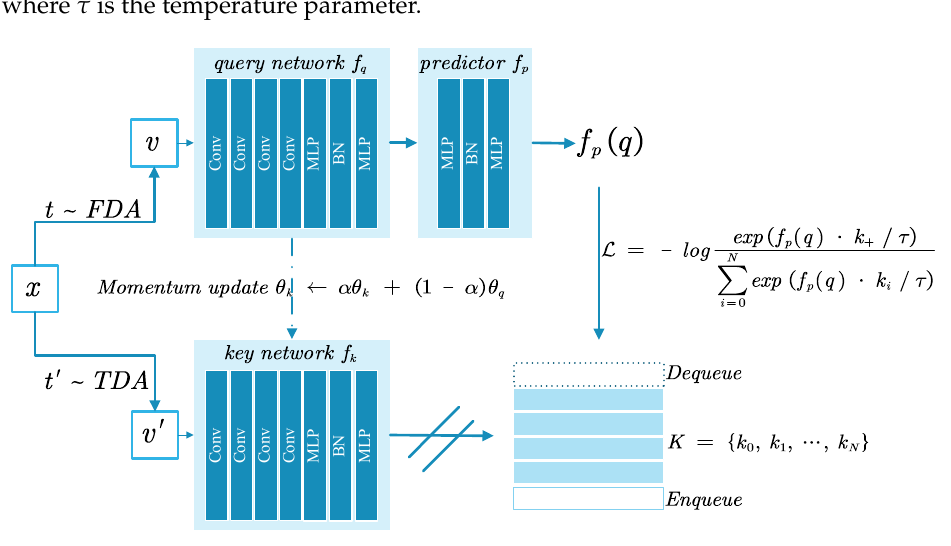
Figure 5. The structure of SMoCo.